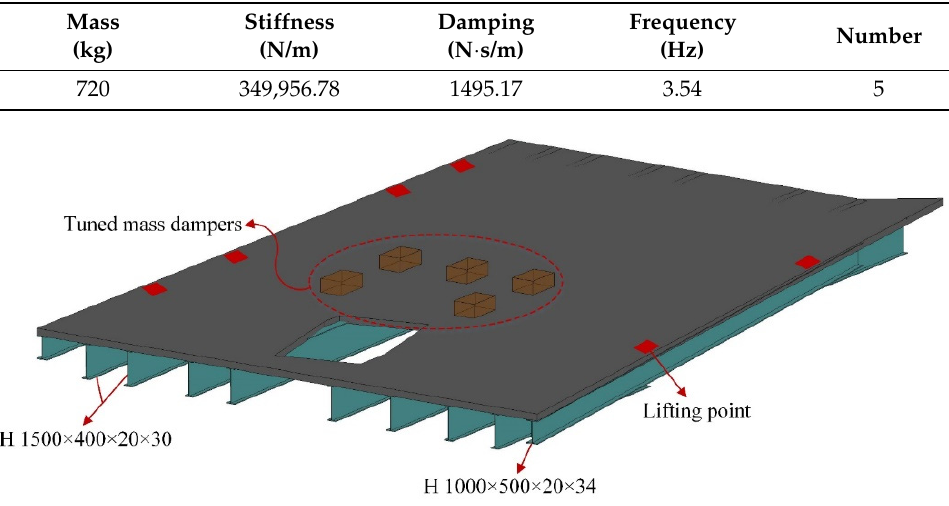
Table 3. The design parameters of TMDs for mitigating vibration of the suspended floor.